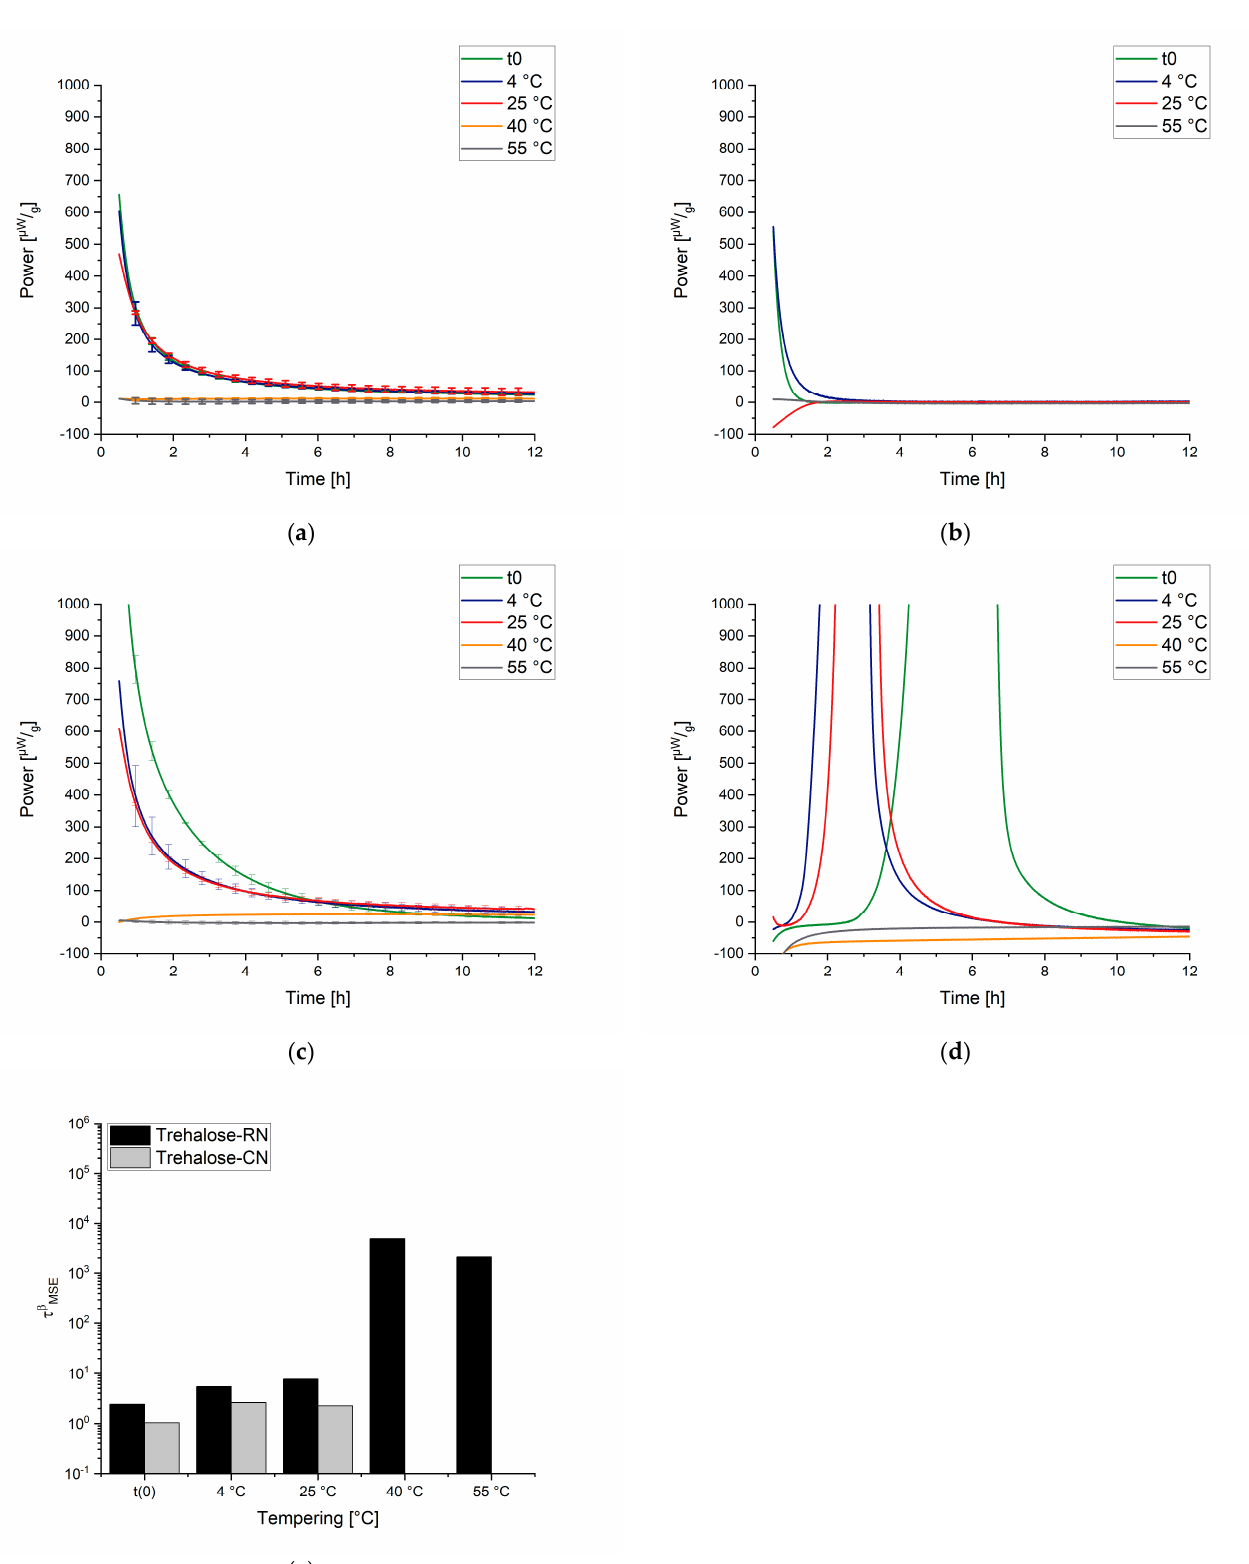
Figure 7. Isothermal measurements performed at 55 °C. Freshly prepared sample (green), 4 °C tempered sample (blue), 25 °C tempered sample (red), 40 °C tempered sample (orange), 55 °C tempered sample (grey). ( a ) Trehalose-RN, ( b ) Sucrose-RN, ( c ) Trehalose-CN, ( d ) Sucrose-CN, ( e ) calculated values of τ β [ h ] . Missing bars indicate unsuccessful curve fitting. Error bars in sucrose samples not shown for better clarity.